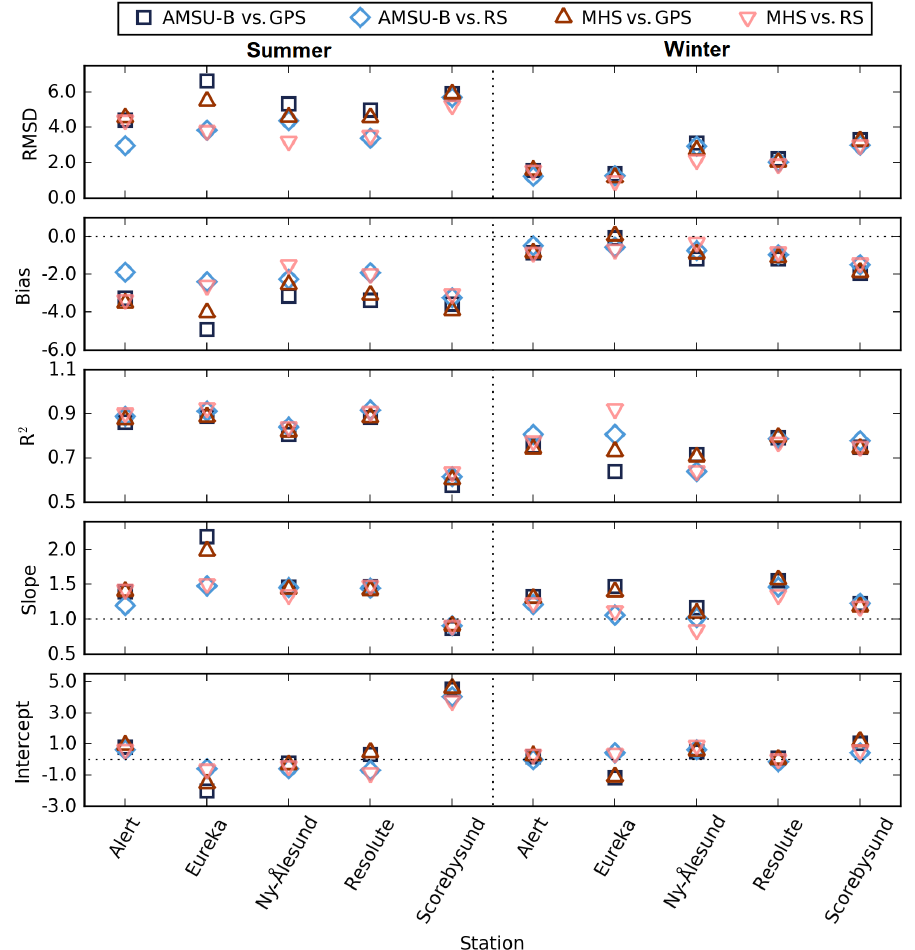
Figure 9. Values of fit parameters for summer (left column) and winter (right column): RMSD, bias, correlation coefficient R 2 , slope, and intercept of regression line for MHS and AMSU-B TWV retrievals vs. radiosonde and GPS TWV retrievals. RMSD, bias and intercept are given in kgm − 2 , and slope and R 2 are absolute